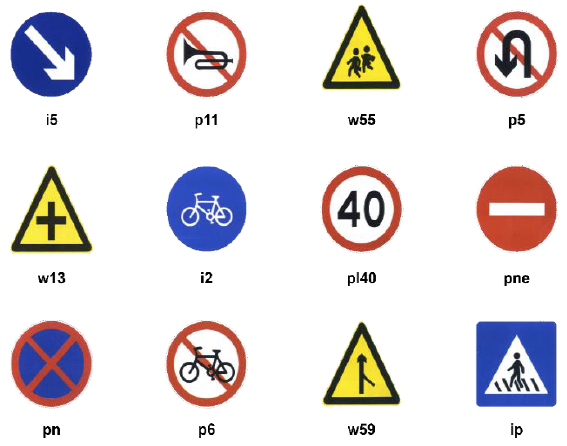
Figure 8. TT100K dataset partial traffic signs and category information.